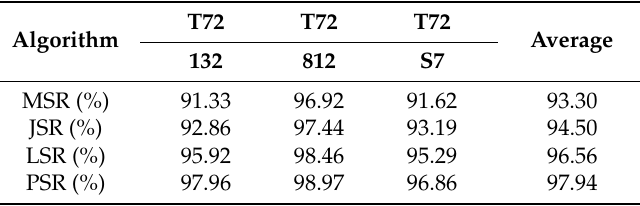
Table 7. The recognition results of each configuration for T72 under the 1024 feature dimensionality.